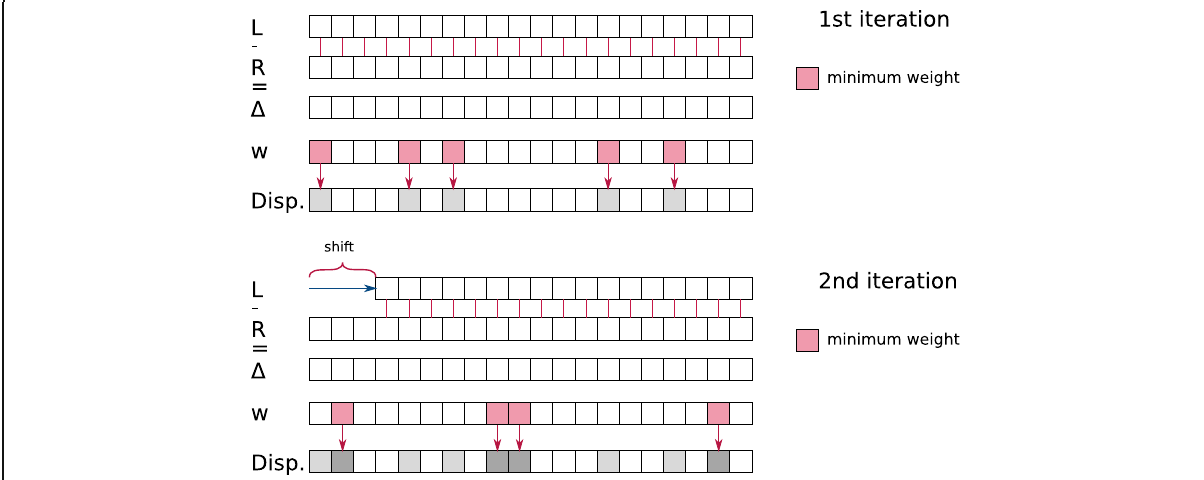
Fig. 2 Illustration of the basic concept of Cyclops2 algorithm. Right and left image rows are first shifted by specified number of columns. Shifted rows are subtracted to produce deltas. Deltas that correspond to minimal weight are used to fill disparity image with current shift value